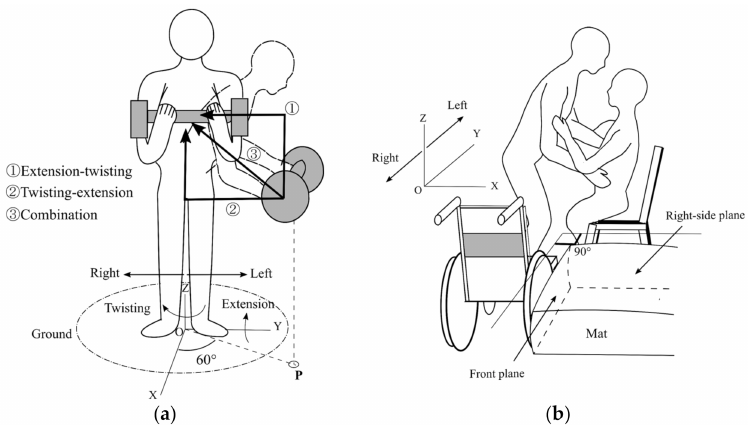
Figure 2. Transfer tasks with ( a ) a 15 kg dumbbell and ( b ) a patient. Point P represents the projection of the center of mass of the dumbbell. In the PT tasks, a mat was placed between the chair and the wheelchair to prevent the subject from falling on the ground. The mat also ensured the wheelchair and the chair aligned with the front plane and right-side plane,